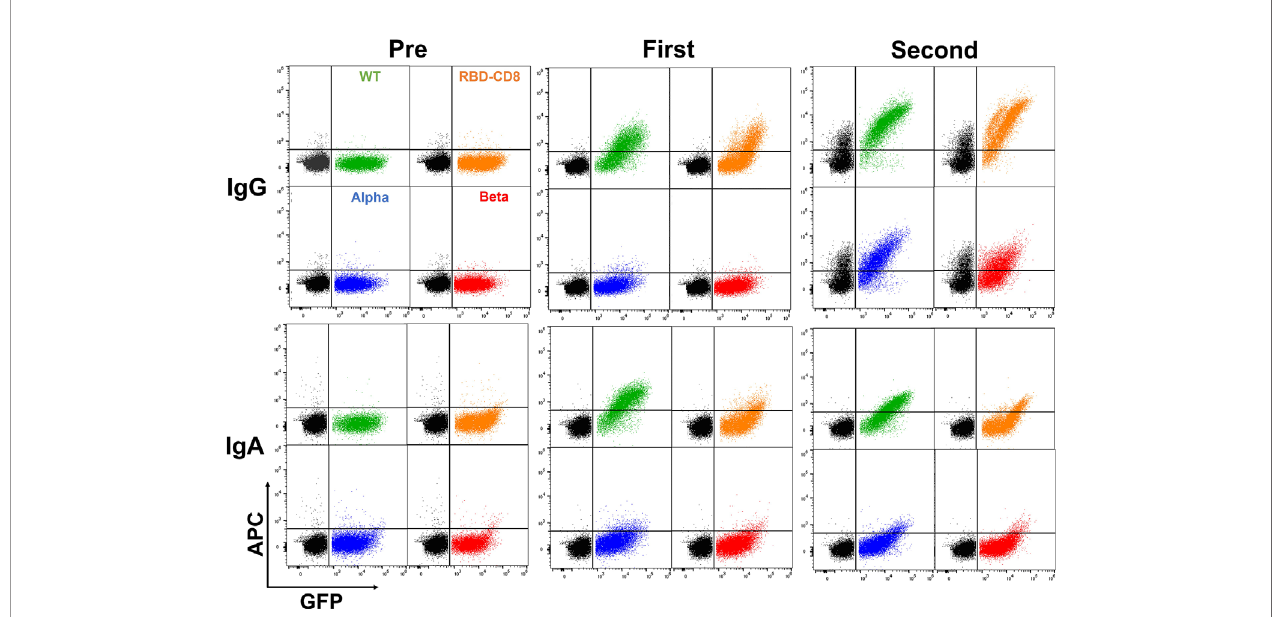
FIGURE 4 | BSFA study of the serum of a vaccinated (BioNTech/P fi zer) 47-year-old female (V7) for anti-S protein IgG (upper panels) and IgA class (lower panels) antibodies. Serum was collected 1 day before (pre) or 12 days after the fi rst vaccination and 10 days after the second vaccination.